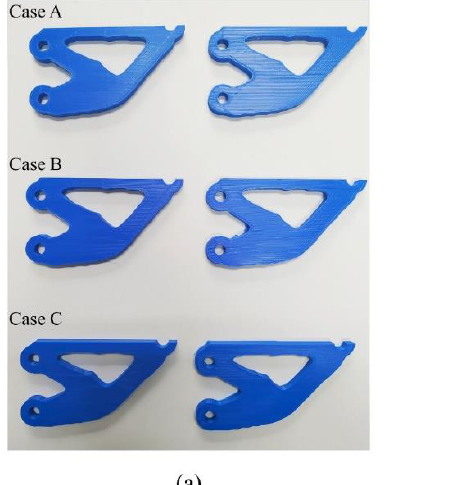
Figure 15. Comparison of the optimized cantilevers by using ( a ) our method and ( b ) the SIMP method.